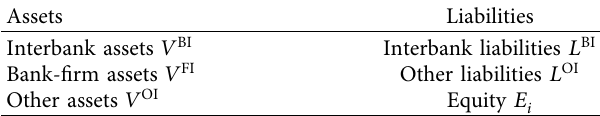
Table 1: Simplified balance sheet of a bank.